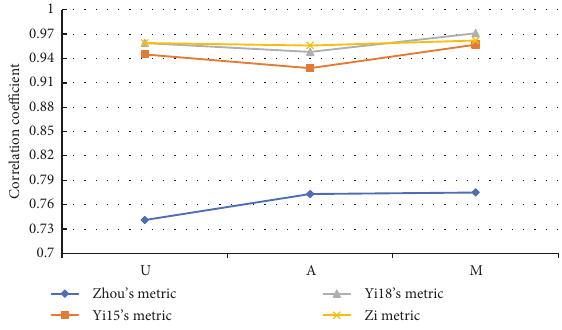
Figure 2: Pearson simple correlation